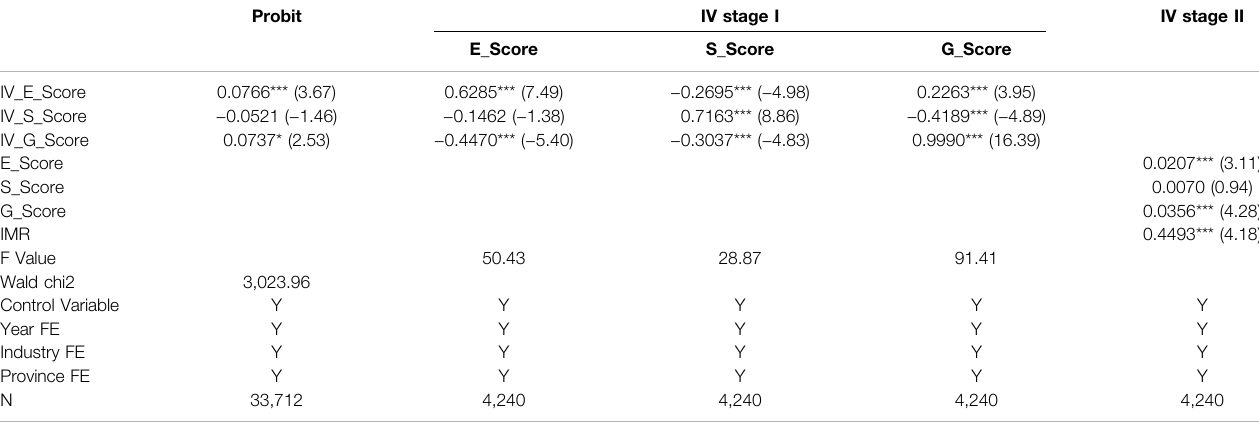
TABLE 7 | IV Regression results (each component of ESG).